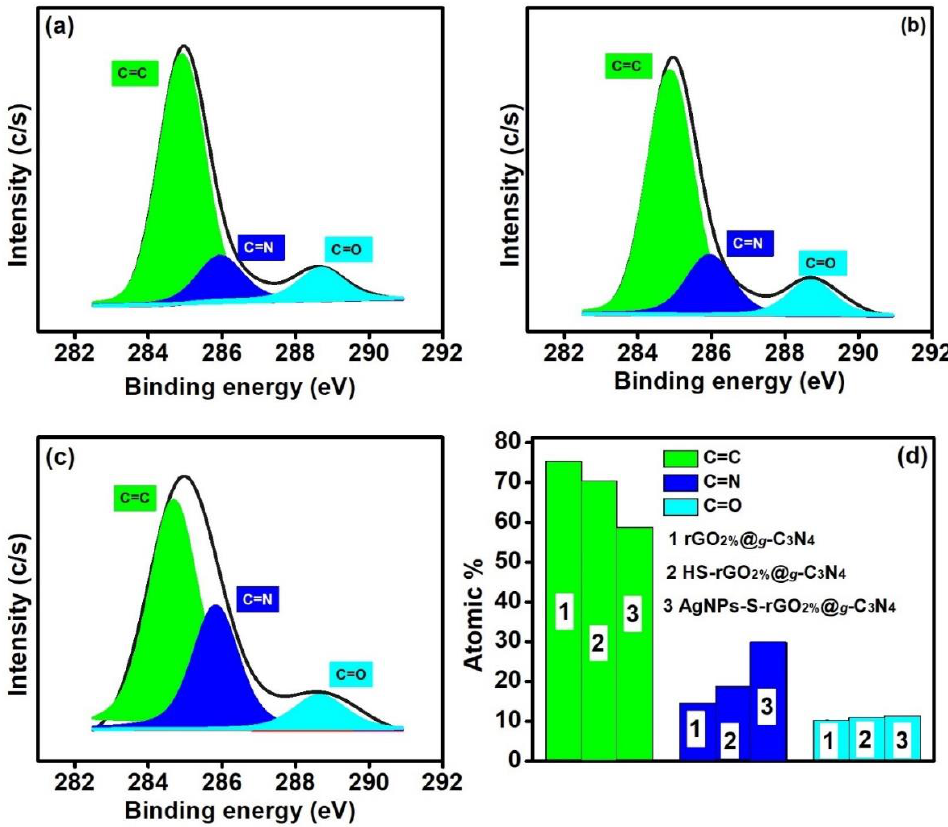
Figure 4. Chemical state analysis of C1s ( a ) rGO 2% @ g -C 3 N 4 , ( b ) HS-rGO 2% @ g -C 3 N 4 , ( c ) AgNPs-S- rGO 2% @ g -C 3 N 4 and ( d ) apparent change in functional groups for rGO 2% @ g -C 3 N 4 , HS-rGO 2% @ g -C 3 N 4, and AgNPs-S-rGO 2% @ g -C 3 N 4 .